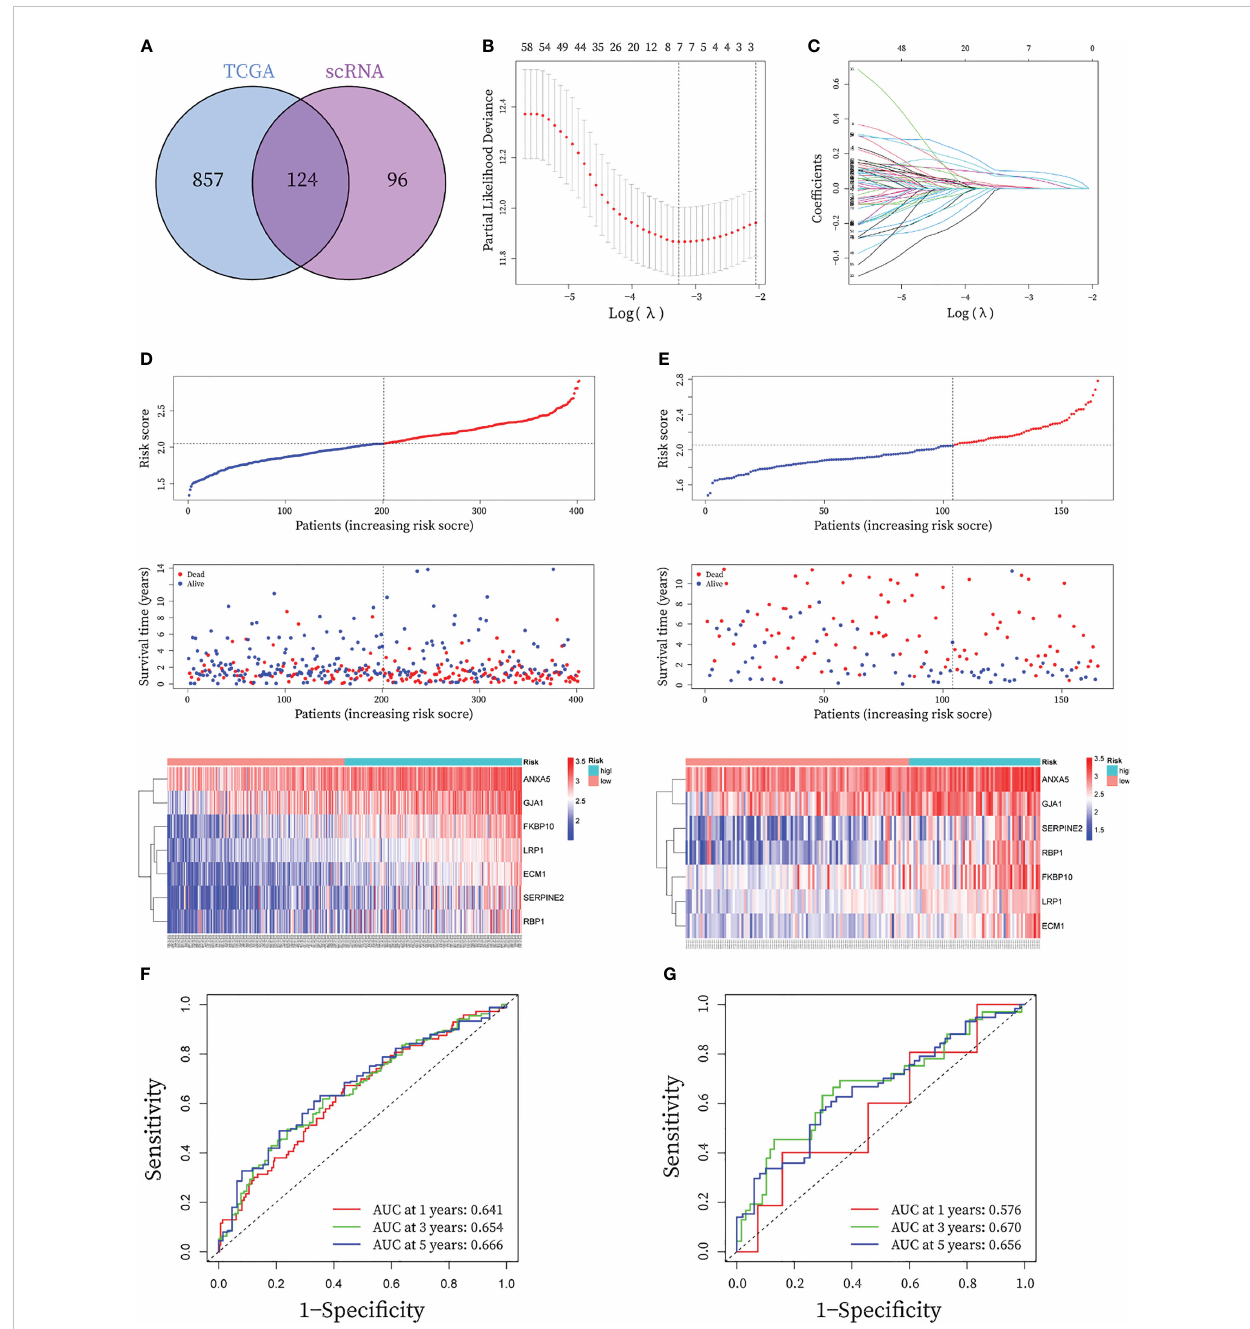
FIGURE 5 Construction and validation of seven-gene prognostic CAF signature for BLCA patients. (A) The Venn graph of the CAF-genes obtained from WGCNA key genes in TCGA cohort and scRNA-seq marker genes. (B) To determine the penalty term parameter ( l ), partial likelihood deviations are displayed. (C) The Lasso regression coef fi cient pro fi les showing the change in coef fi cients for different variables with the l penalty (D-E) Risk plot distribution, survival status of patients, and heatmap of expression of seven CAF-genes in the (C) TCGA cohort and the (D) GEO cohort. (F-G) Receiver operating characteristic (ROC) curves for the CAF signature in the (E) TCGA cohort and the (F) GEO